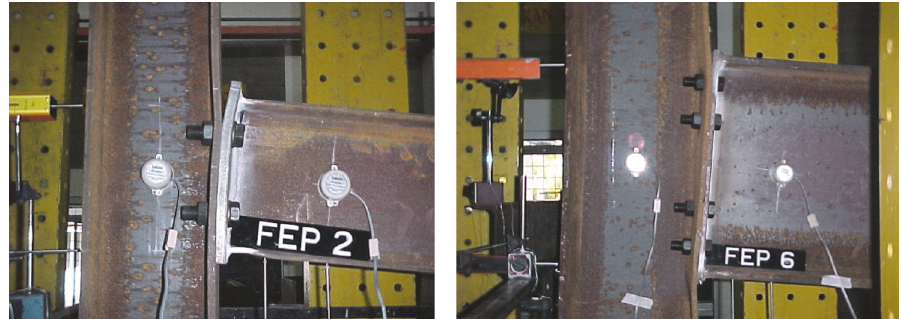
Figure 9: Failure mode at the end of the test.